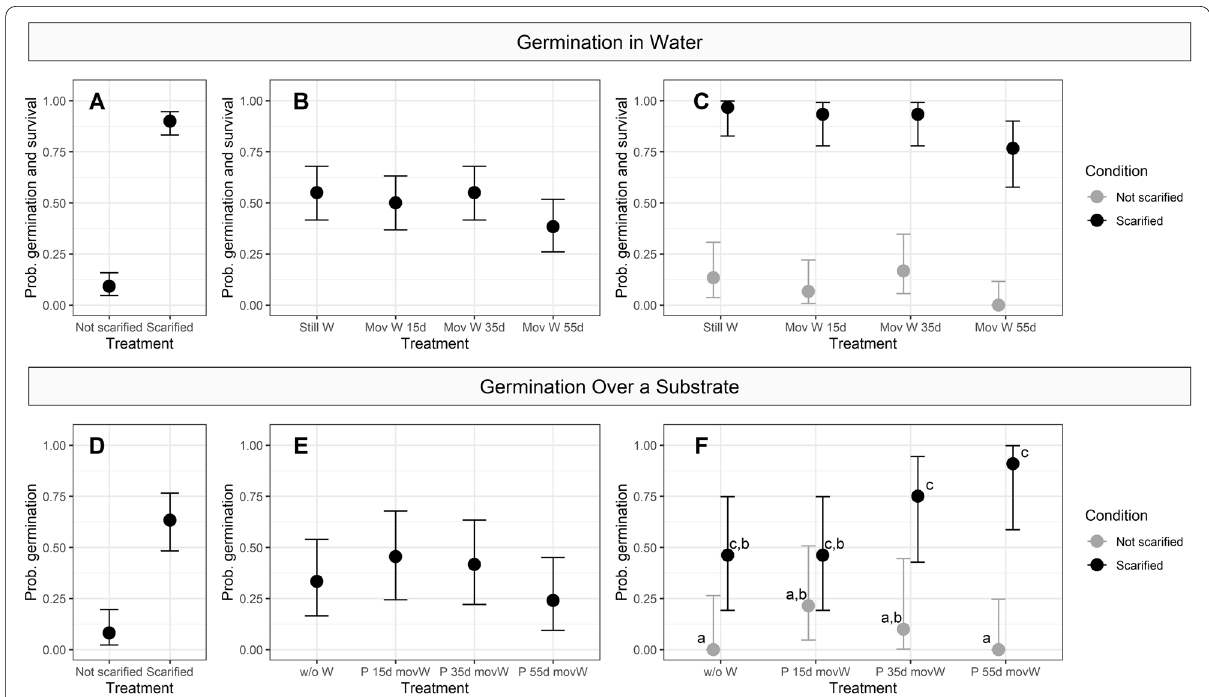
Fig. 2 Germination rates for each experiment. A Germination rates for the two seed conditions (scarified vs. unscarified), in the ‘germination in water’ experiments, pooling across all treatments. B Germination rates for each one of the four treatments in the ‘germination in water’ experiments, pooling across both seed conditions (scarified and unscarified). C Germination rates for each combination of seed condition (scarified or unscarified) and treatment, in the ‘germination in water’ experiments. D Germination rates for the subsequent ‘germination over a substrate’ experiment, for each of the two seed conditions (scarified and unscarified), pooling across treatments. E Germination rates for each one of the four treatments in the ‘germination over a substrate’ experiments, pooling across both seed conditions (scarified and unscarified). F Germination rates for each combination of seed condition (scarified or unscarified) and treatment, in the ‘germination over a substrate’ experiments. Letters indicate homogeneous groups as suggested by an a-posteriori analysis. The different treatments are explained in Fig. S1